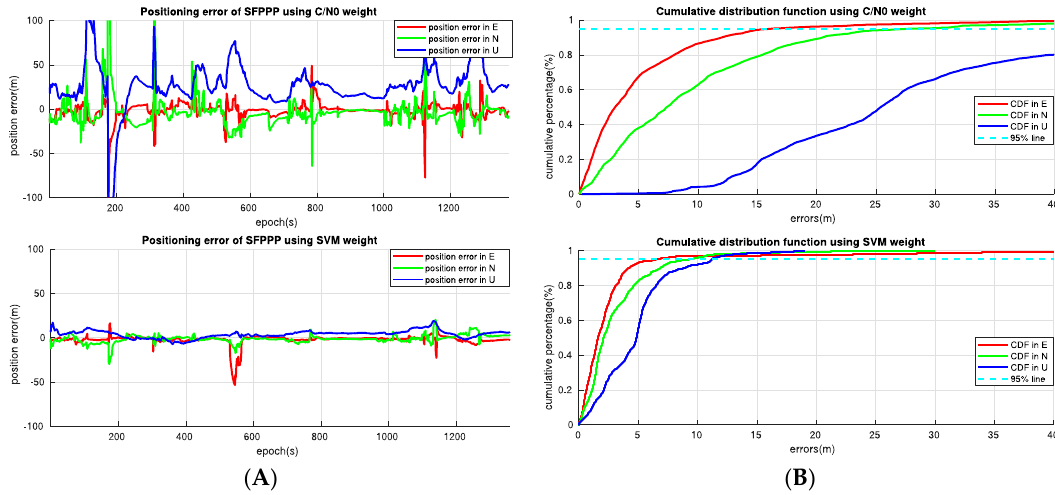
Table 4. Positioning accuracy improvement compared to traditional C/N0 weight model.